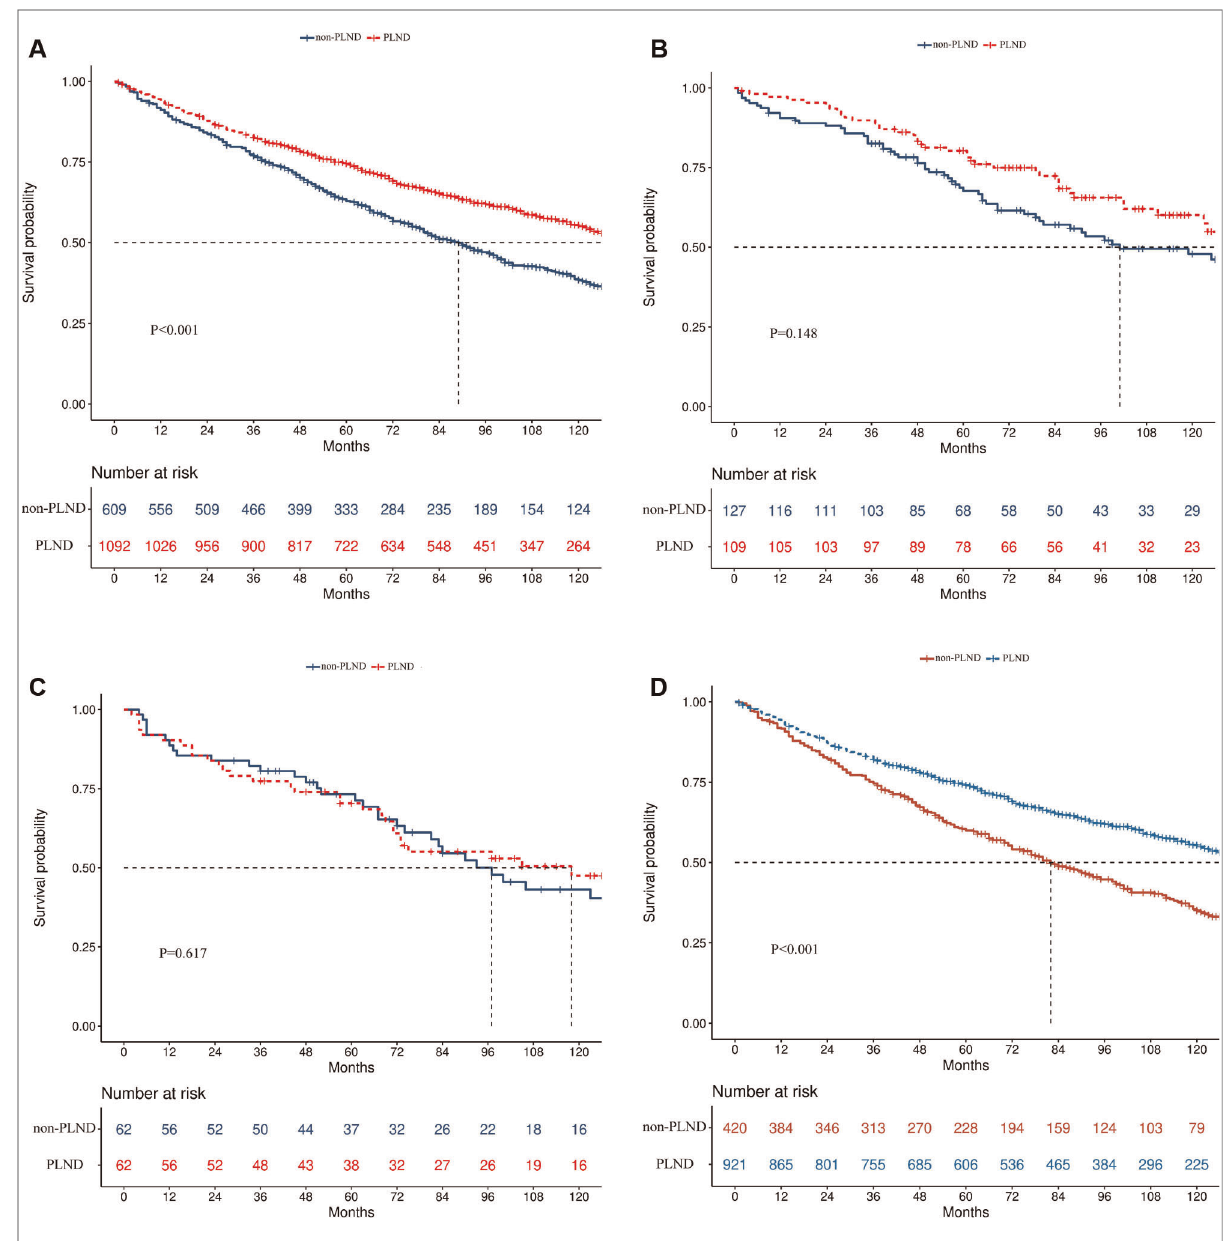
FIGURE 2 Kaplan – Meier survival curves in the complete cohort ( A ), Ta ( B ), Tis ( C ), and T1 ( D ) disease